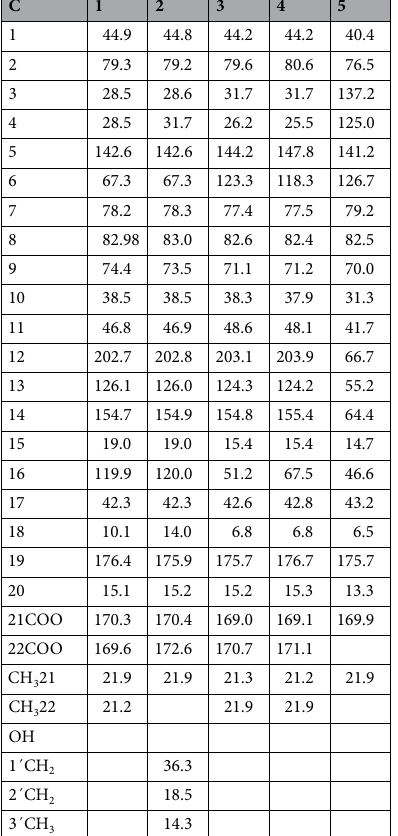
Table 2. 13 C NMR data ( δ in ppm) of briaranes 1–5 at 125 MHz in CDCl 3 .